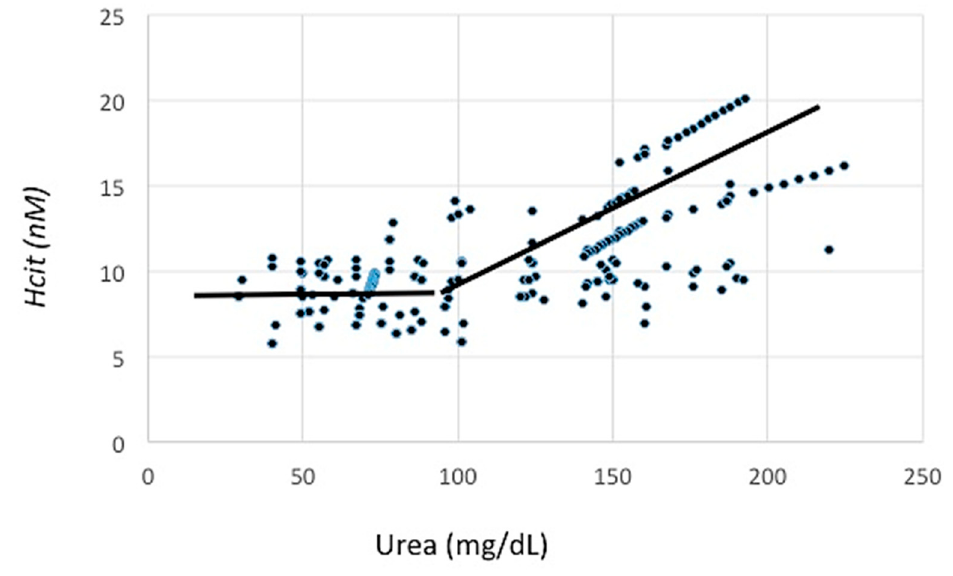
Figure 1. Variation of homocitrulline and urea and break point.